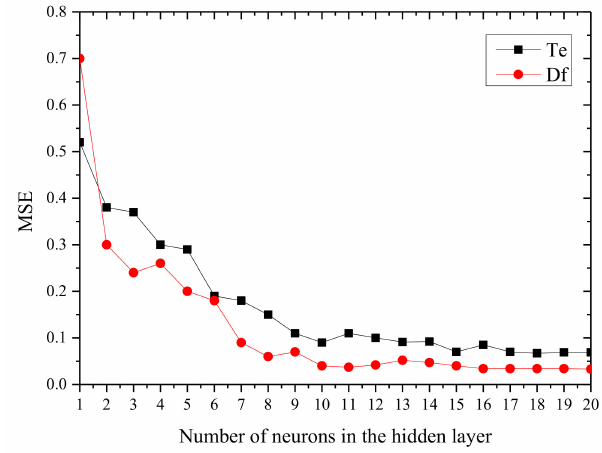
Figure 13. Mean square error (MSE) of a three-layer neural network with di ff erent neurons in the hidden layer. (Black colour: ignition temperature. Red colour: burnout